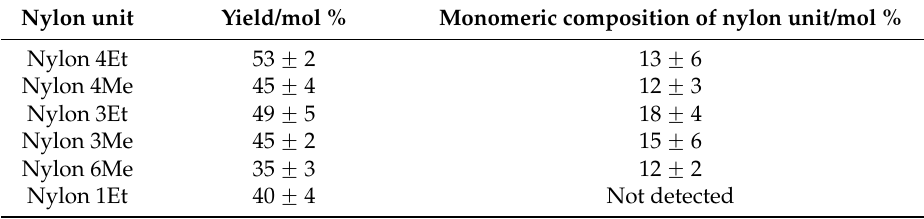
Table 1. Reaction yields and monomeric compositions of the nylon units in the papain-catalyzed synthesis with Glu(Et) 2 ( n = 3).